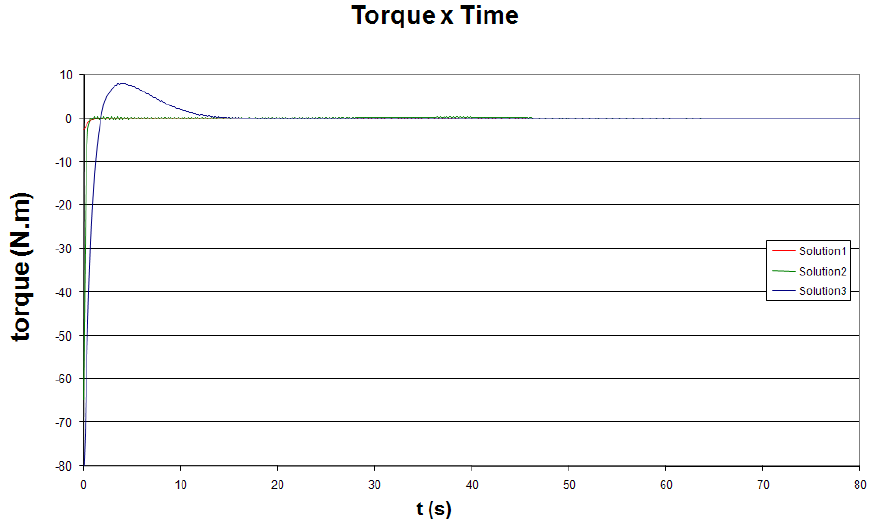
Fig. 7. Torques of the three solutions 1, 2 and